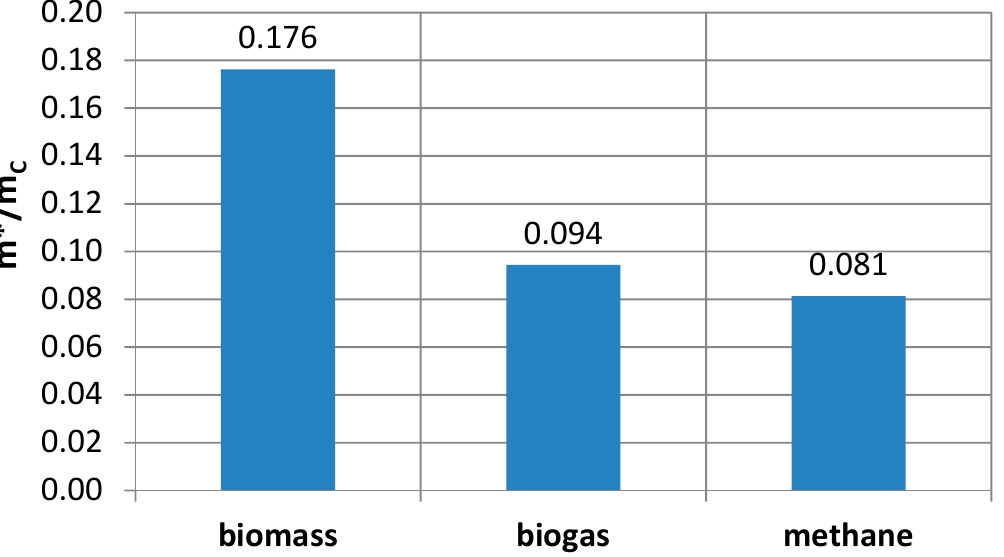
Figure 12. The influence of the calorific value of the fuel on the relative mass stream of the bypass to the mass flow of air flowing through the compressor for the optimal compression ratio.